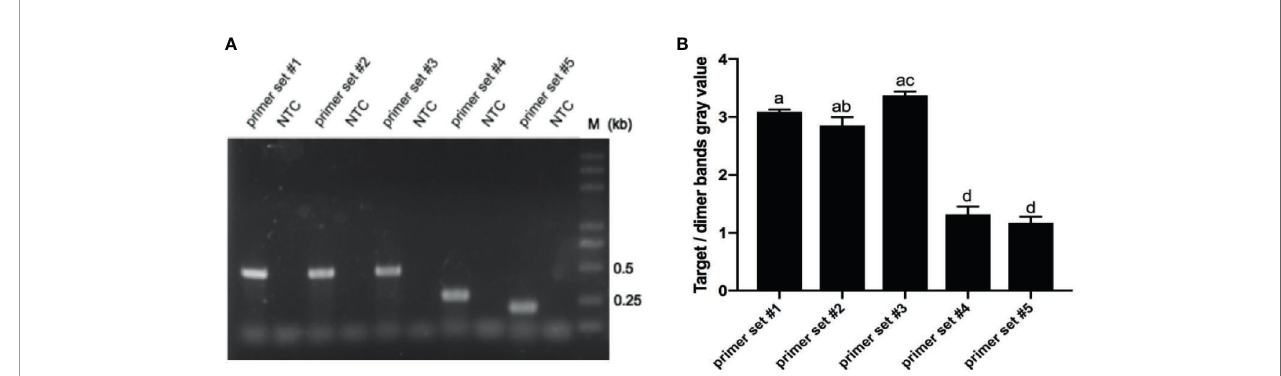
FIGURE 1 | RPA primer sets screen. (A) Primer sets of #1-5 were screened using RPA assays with P. aeruginosa standard strain genomic DNA as templates. A no template control (NTC) for each primer set was used as a negative control. Equal volumes of ampli fi cation products (5 m L) were detected on 1.5% agarose gel through electrophoresis. (B) Gray values of target/dimer bands were measured using ImageJ software by measuring the parameters of gray value and area, and calculated using Excel software. Results are mean ± SEM of triplicate experiments. Bars with different lowercase letters are signi fi cantly different ( p <0.05) while bars with identical lowercase letters are not signi fi cantly different ( p >0.05). Samples are indicated on the top of the